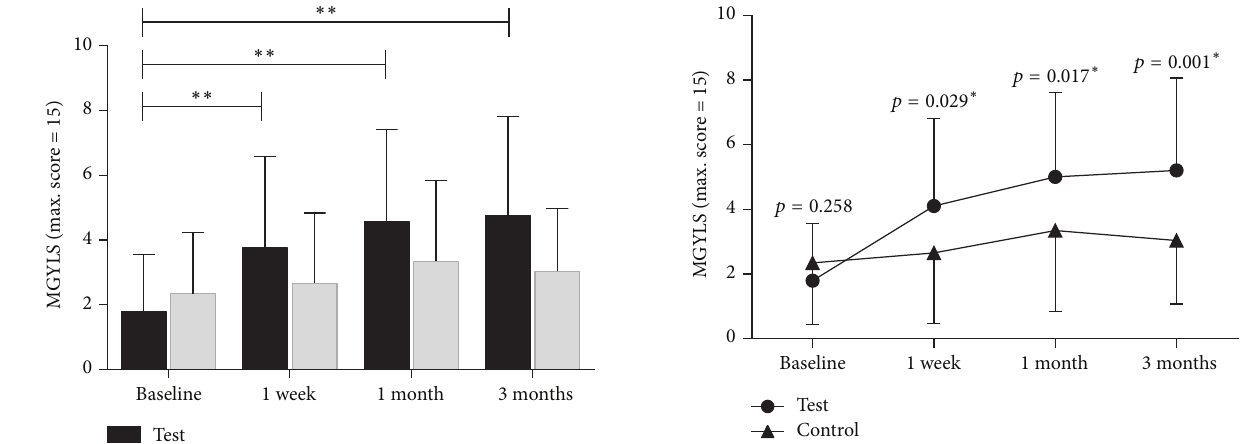
Figure 10: Time course of meibomian glands yielding liquid secretion (MGYLS). Circle: test eye; triangle: control eye. There was a significant change between the test and control eye ( 𝑝 = 0.019 ). Differences of each point (one week, one month, and three months) posttreatment visit were labeled above the line ( ∗ 𝑝 < 0.05